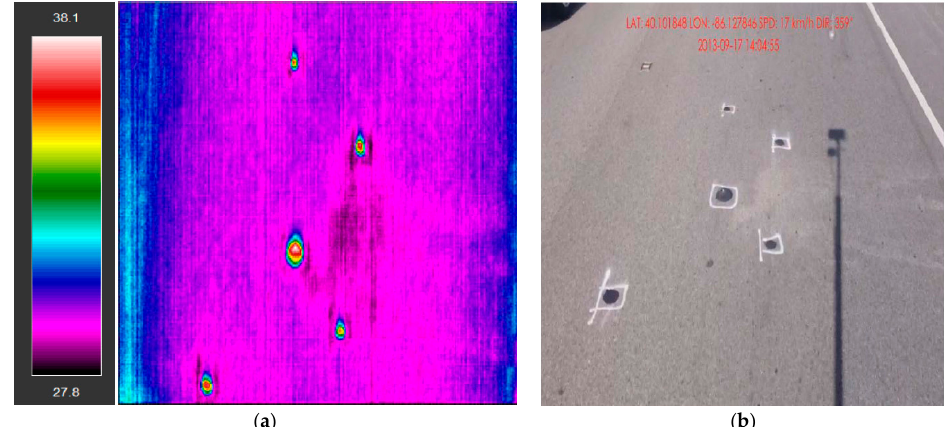
Figure 4. Clay ball images from ( a ) IR camera and ( b ) right way of camera.